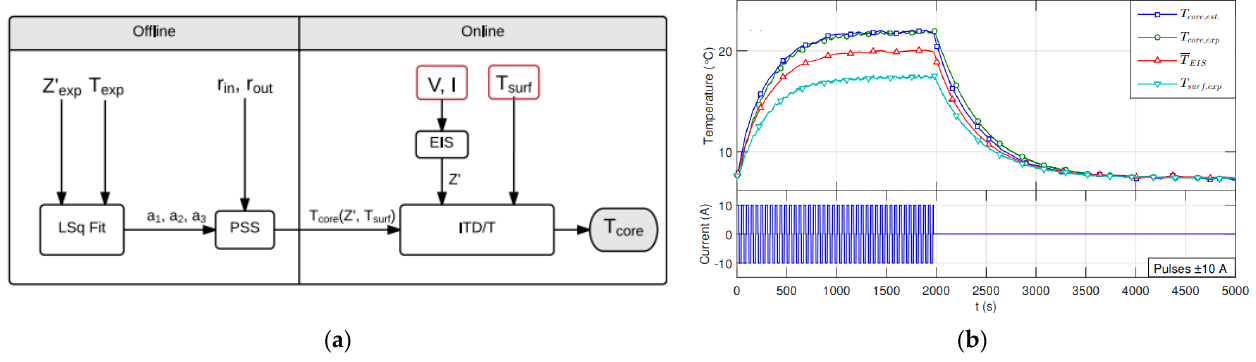
Figure 13. ( a ) A description of the Hybrid method of temperature estimation in an impedance-based model. Reprinted with permission from [44] . Copyright 2016 Elsevier. ( b ) Model estimates and current pulse experimental results: ± 10 A [42,43,68]. Reprinted with permission from [69]. Copyright 2014 Elsevier.